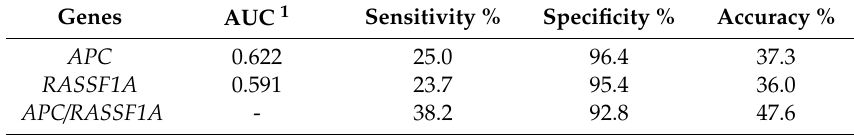
Table 3. Biomarker performance of promoter gene methylation for LCa detection in plasma samples. Genes AUC 1 Sensitivity % Specificity % Accuracy % APC 0.622 25.0 96.4 37.3 RASSF1A 0.591 23.7 95.4 36.0 APC/RASSF1A - 38.2 92.8 47.6